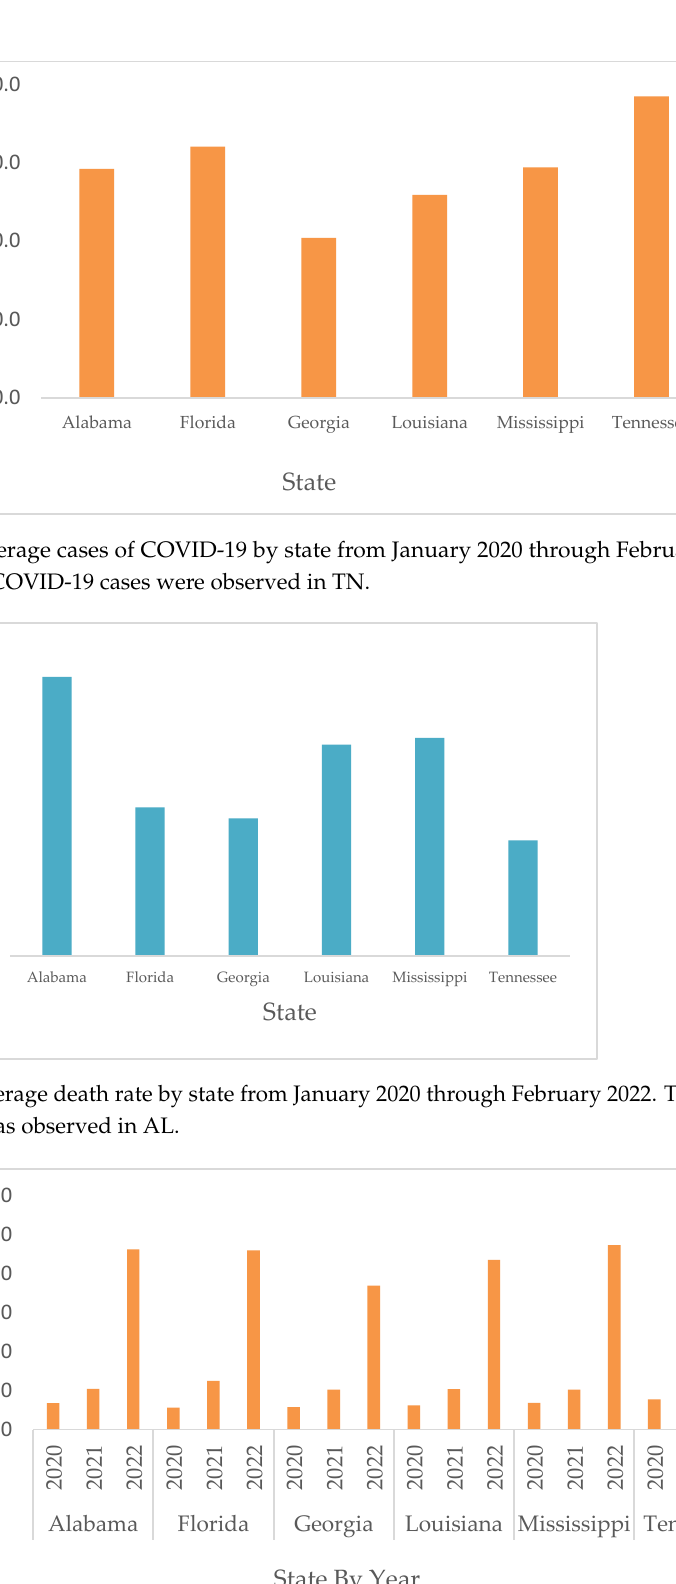
Figure 3. Average numbers of cases of COVID-19 per state from March 2020 through February 2022.